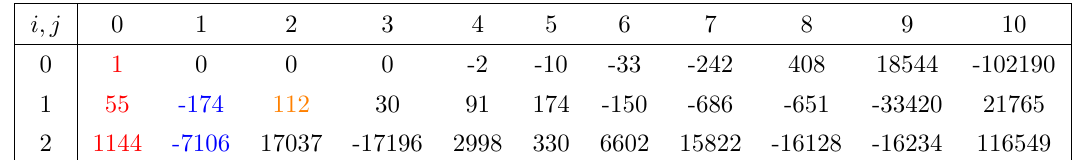
Table 19 . Series coefficients c i,j for the one-string elliptic genus of n = 2 so (11) model.